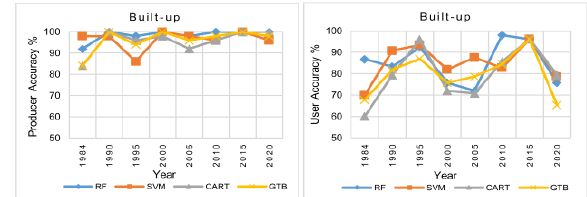
Figure 6 : Maximum margin-minimum norm classifier in SVM with optimal decision hyperplane for non-separable classes. Figure 7 . PA and UA results for urban